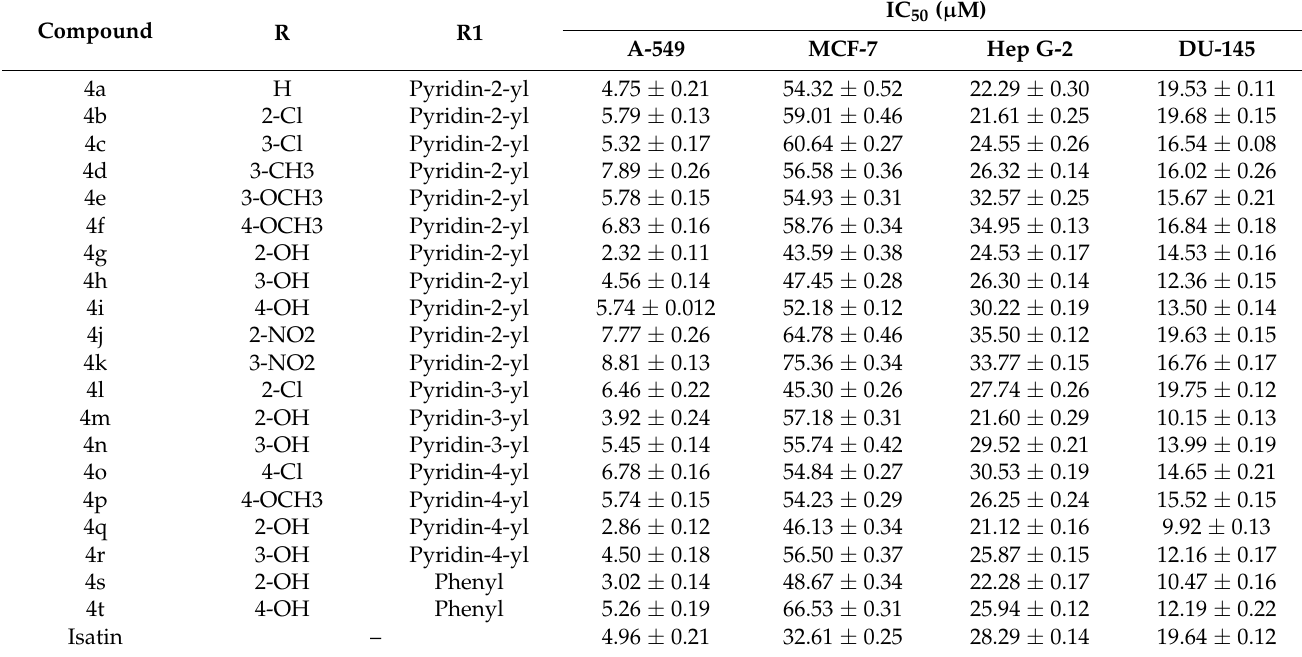
Table 3. Anticancer potential of compounds 4(a–t) in select experimental human cancer cell lines.